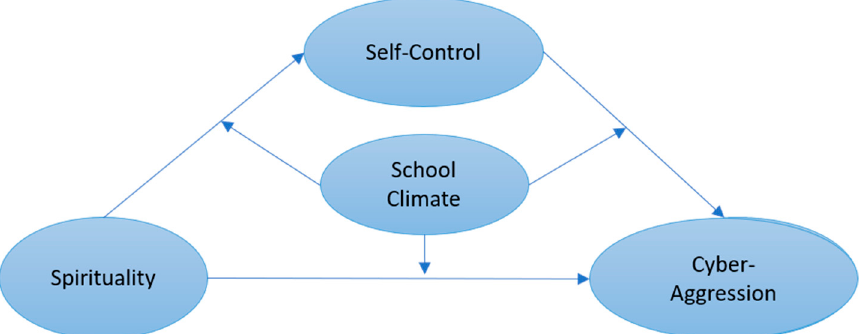
Figure 1. Relationships between Variables